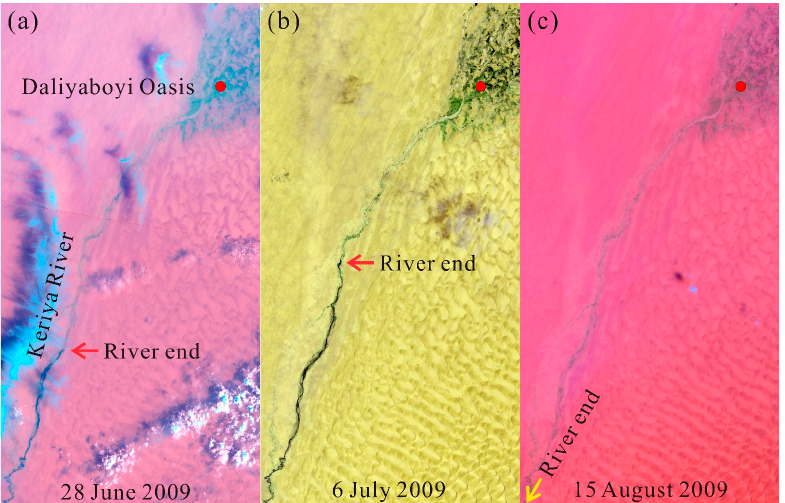
Figure 9. Landsat images showing the hydrological surface water conditions along the lower Keriya River from June to August 2009. ( a – c ) are Landsat images captured on 28 June 2009, 6 July 2009, and 15 August 2009, respectively. The three Landsat images show no flood flows into the Daliyaboyi Oasis in the summer of 2009; thus, no inundation occurred.